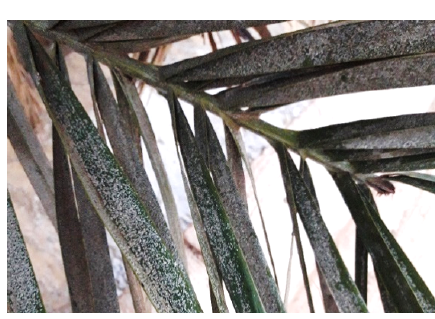
Fig. 1 Example of a palm tree infected by white